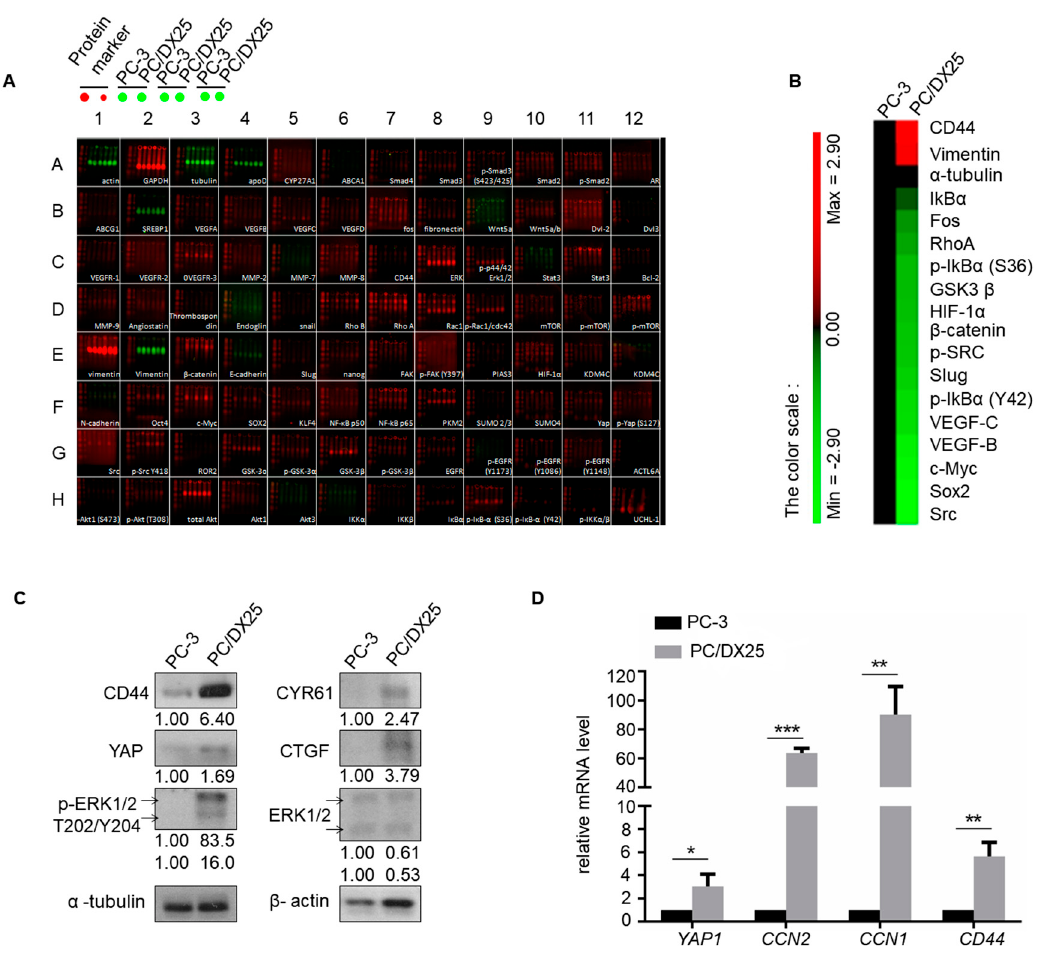
Figure 3. Profile of proteins regulating cell migration and invasion in PC3 vs. PC/DX25 cells as determined by Micro-Western Array and Western blotting. ( A ) Expression of proteins regulating cell migration and invasion in PC-3 cells and PC/DX25 cells was determined by Micro-Western Array (MWA) with 192 different antibodies. A representative image MWA was shown. ( B ) Results of MWA in (A) were demonstrated by heatmap. ( C ) Protein expression of CD44, YAP, CYR61, CTGF, phospho-ERK1/2 T202/Y204 and ERK in PC-3 and PC/DX25 cells was determined by Western blotting assay. The α -tubulin was used as loading control. ( D ) Gene expression of YAP1 , CCN2 (gene of CTGF), CCN1 (gene of CYR61) and CD44 was determined by real-time quantitative PCR. Asterisks *, **, *** represent statistically significant difference of p value < 0.05, p value < 0.01, and p value < 0.001, respectively.